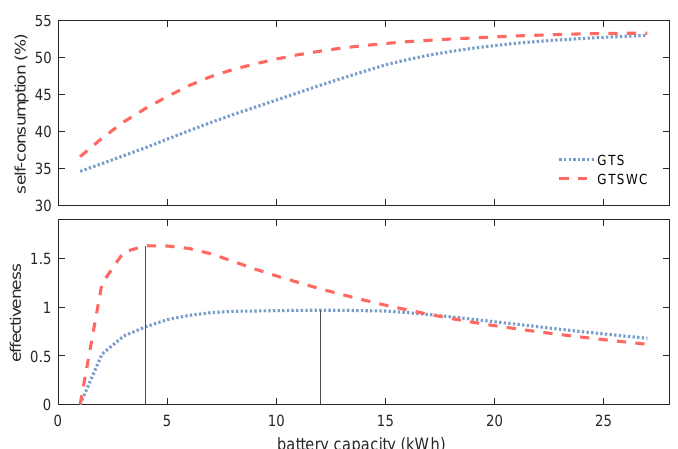
Figure 1. Optimal sizing considerations. The self-consumption and the resulting effectiveness of an exemplary household are plotted over the battery size. The two vertical lines indicate the maximum of the effectiveness for the Game-Theoretic Scheduling (GTS) and Game-Theoretic Scheduling With Constraint (GTSWC) approaches and therefore the optimal size of the energy storage installation, respectively.